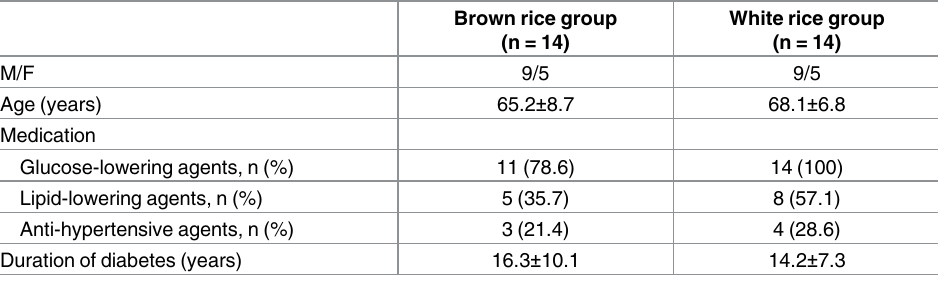
Table 1. Characteristics of participants at baseline.